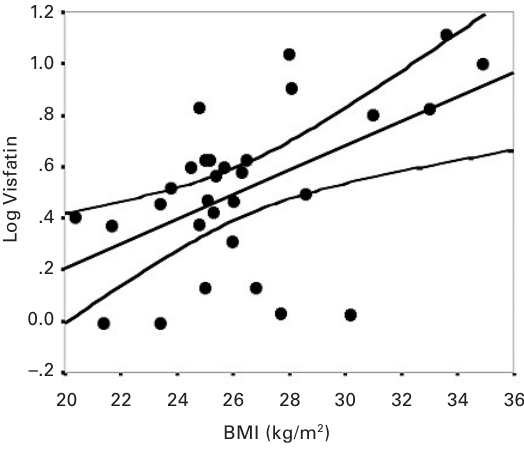
and body mass index in obese children (B = 0.058 [95% confidence